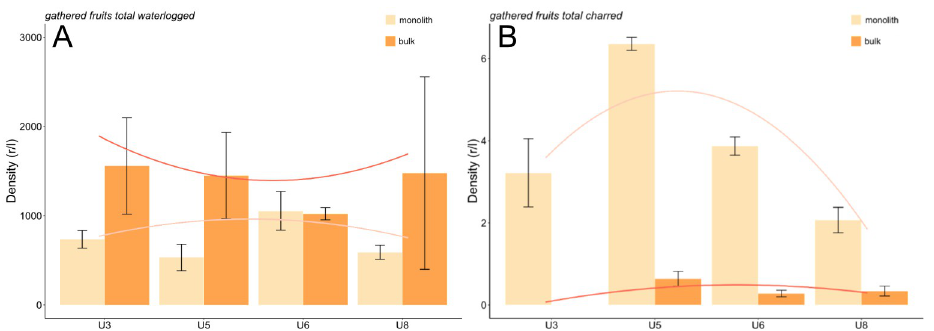
Fig 14. A, B Density of gathered fruits (summed density, waterlogged and charred preservation) (mean ± standard error).